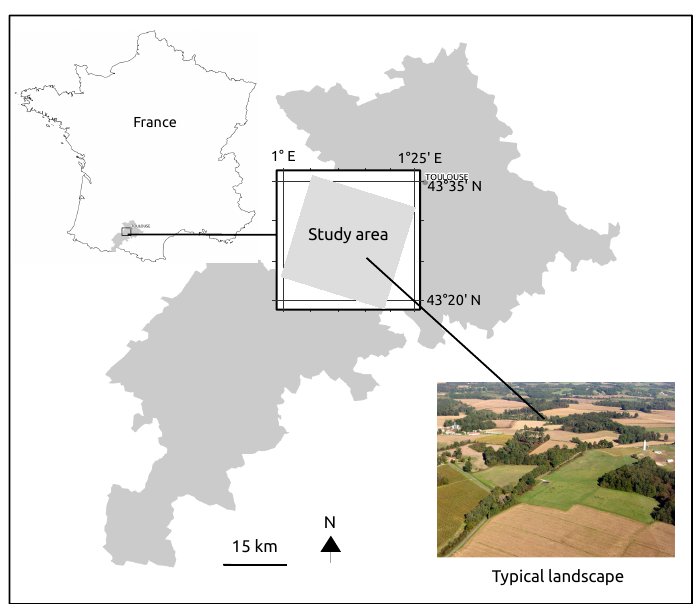
Figure 1. Location of the study area in southwest